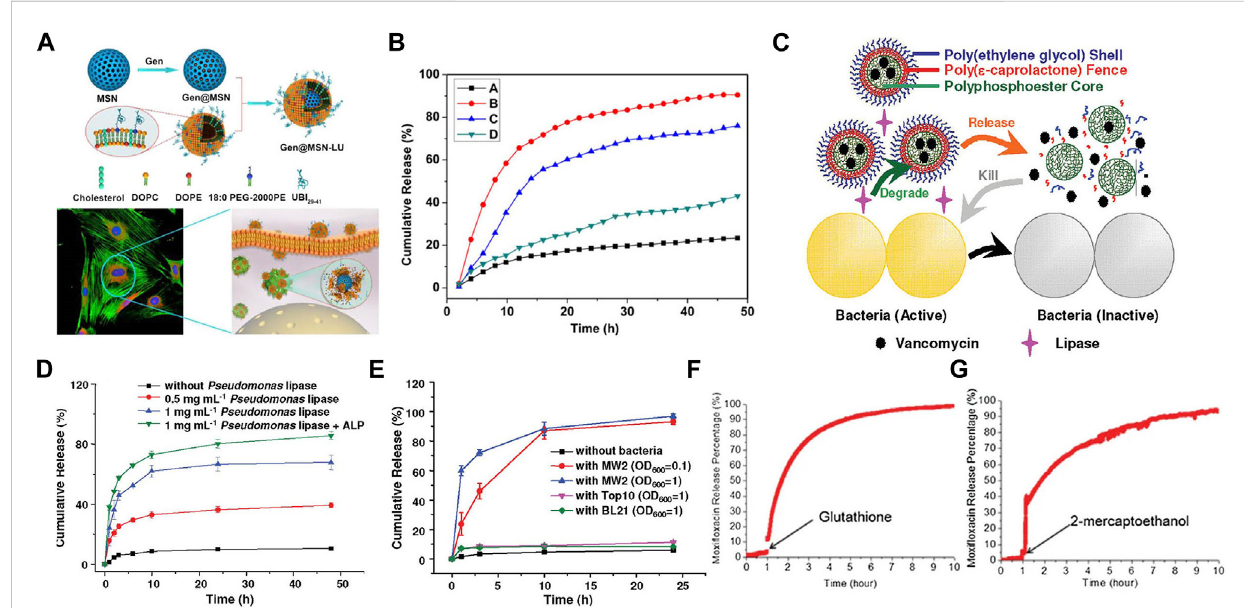
FIGURE 4 (A) Schematics of Gen@MSN-LU, in which the outer layer of liposomes can be degraded by the bacterium-secreted toxins, resulting in the Gen release. (B) The release pro fi le of Gen from Gen@MSN-LU in different treatments (A control; B in the presence of S. aureus ; C with lipase; D with lipase inhibitors in the presence of S. aureus ). (C) Schematics of bacterial lipase triggered release of vancomycin to treat the bacterial infections. (D,E) Cumulative release of vancomycin from vancomycin-loaded TLN in different treatments. (F,G) The behavior of the redox-triggered release